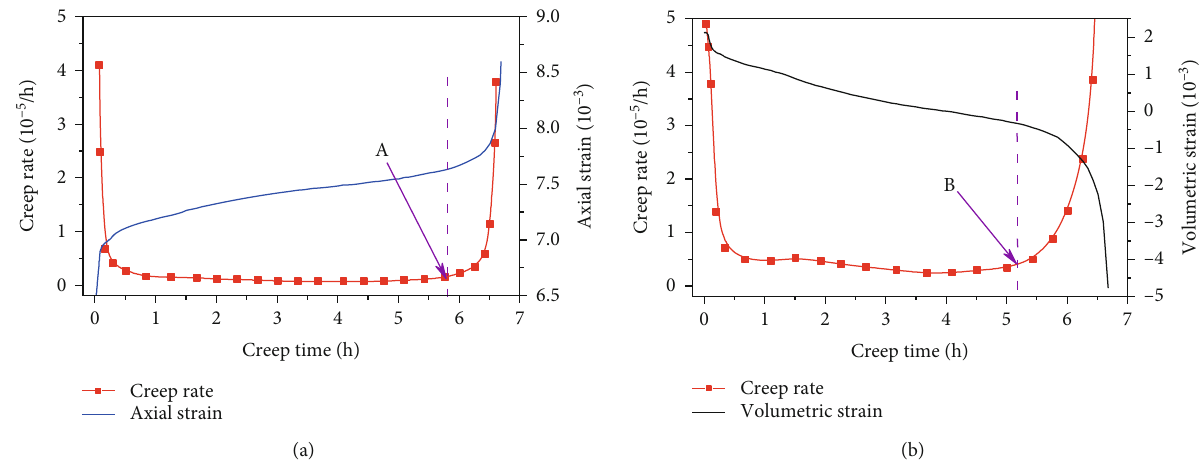
= 6 MPa and Δ P = 1 : 9 MPa : (a) axial strain and rate versus time and (b) volumetric strain 3